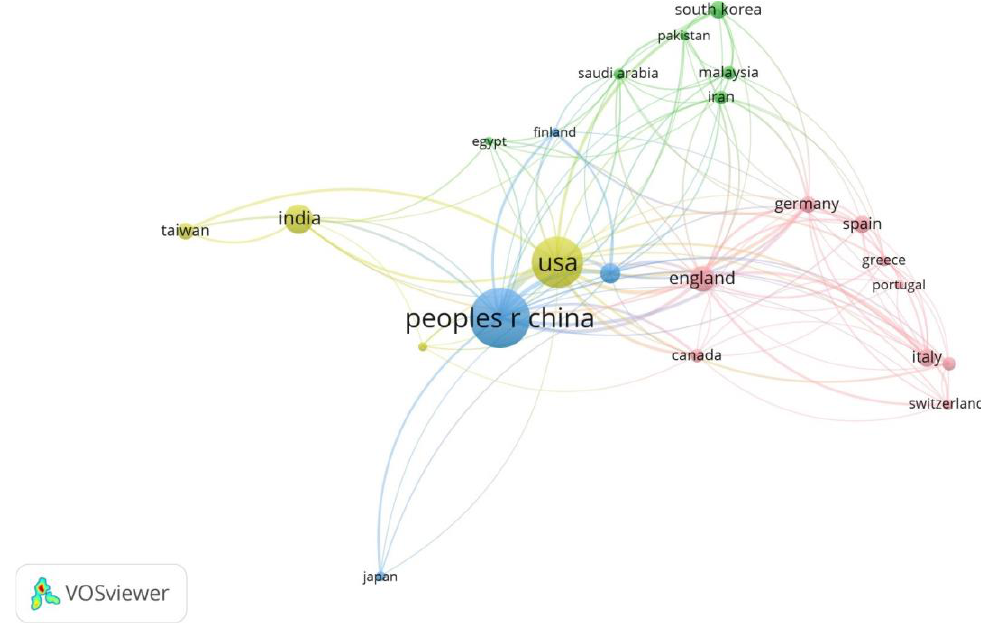
Figure 7. Map of co-authorship of prominent countries. Table 6. Ten most cited papers indexed in